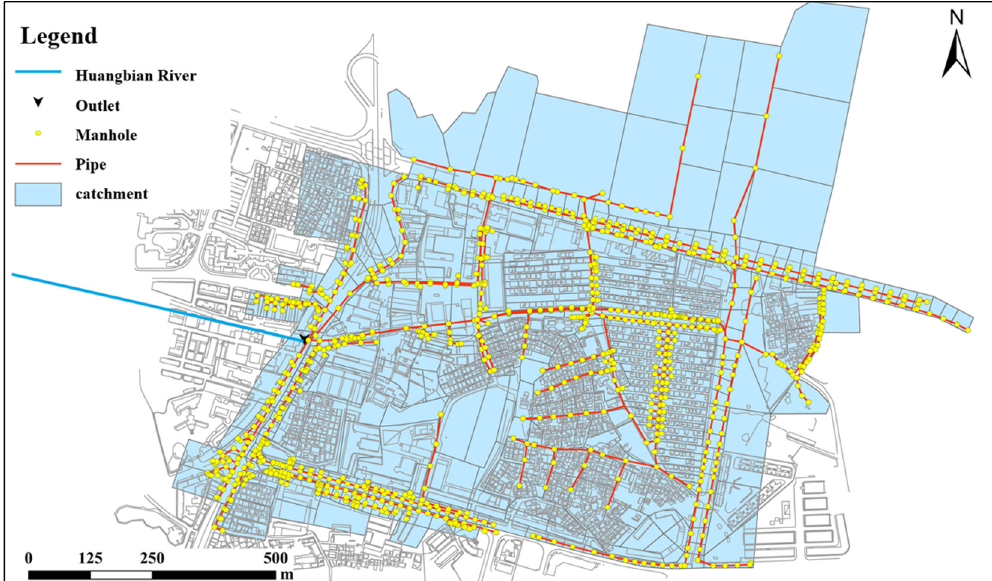
Figure 2. Schematic of Huangbian Village pipe network model.